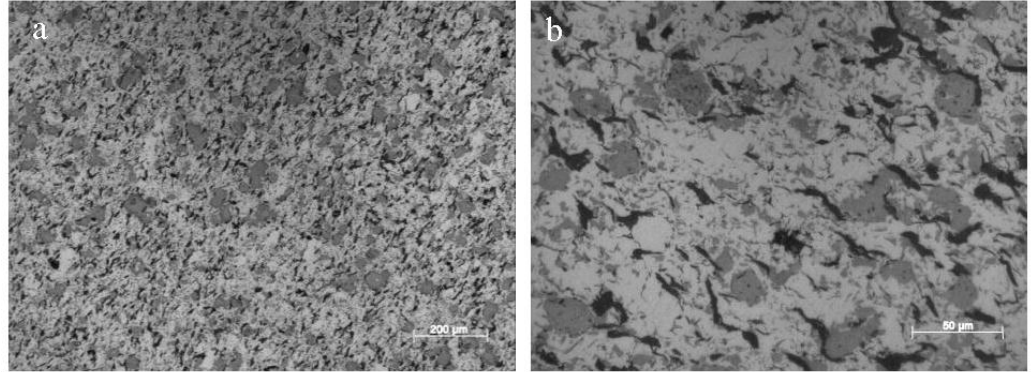
Figure 4. Metallographs of composite along parallel direction to that of the compact-pressing: ( a ) 100×; ( b ) 500×.